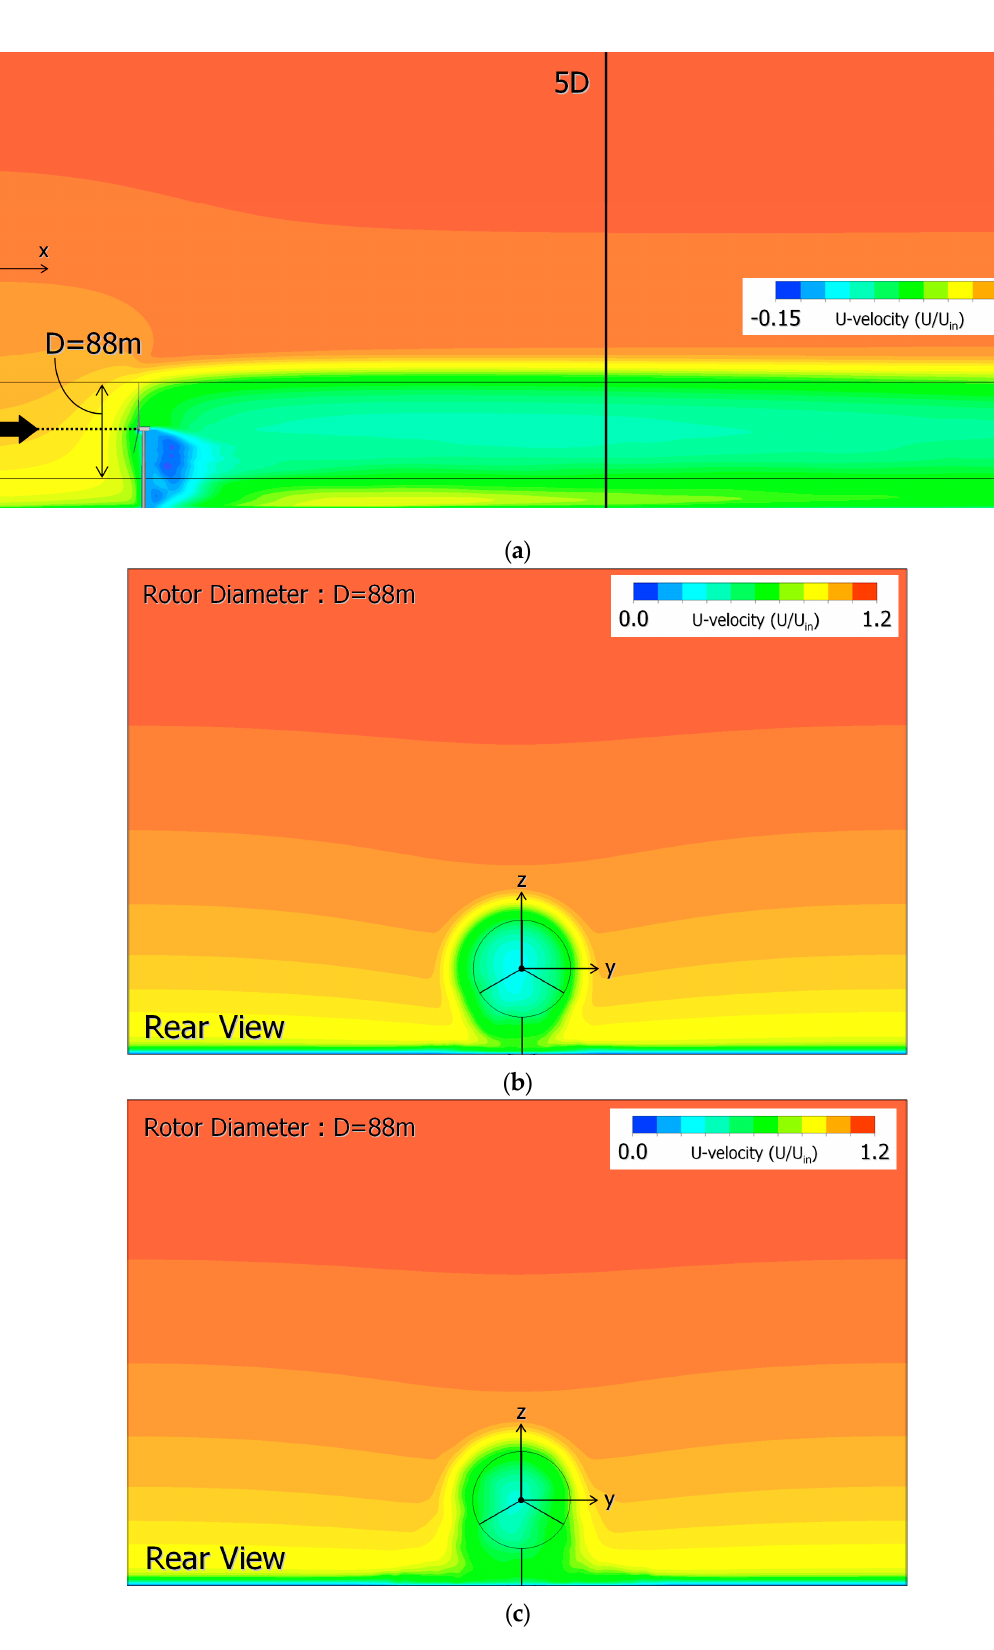
Figure 18. Simulation results of time-averaged field for a real wind turbine (C RC = 10.0), spatial distribution of time-averaged U-velocities, and LES using the CFD PD wake model. ( a ) Side view; ( b ) rear view, x = 5D (near wake region); ( c ) rear view, x = 10D (far wake region).